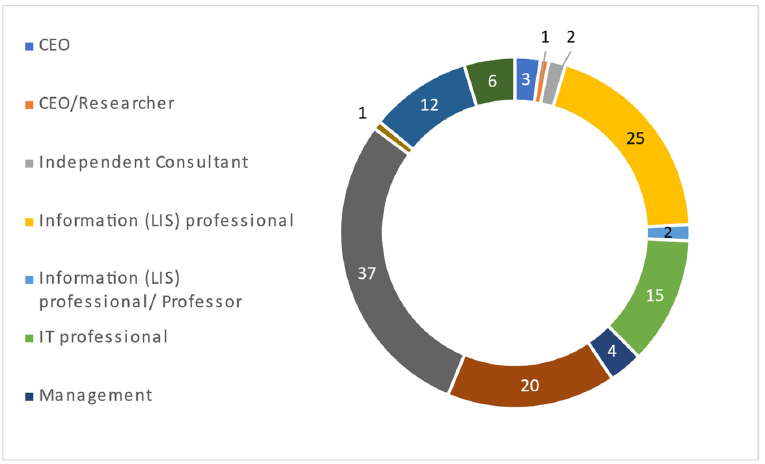
Figure 2. Authors’ Professional